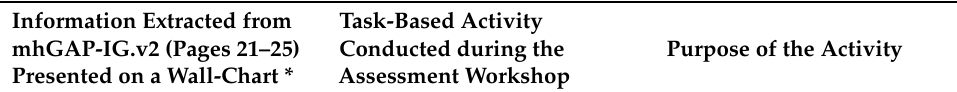
Table 1. Task-based activities employed during workshops to compare participant approach towards the assessment of depression in comparison to